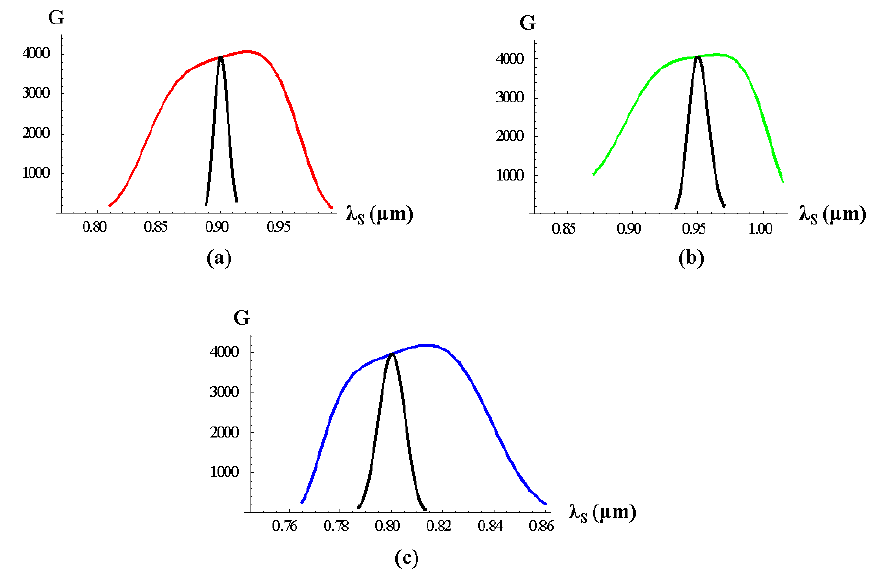
Figure 13. The orientation of nonlinear crystals for UBB phase-matching bandwidth, type I ( oo → e ) parametric interaction. ( a ) DKDP crystal. ( b ) BBO crystal. ( c ) LBO crystal.